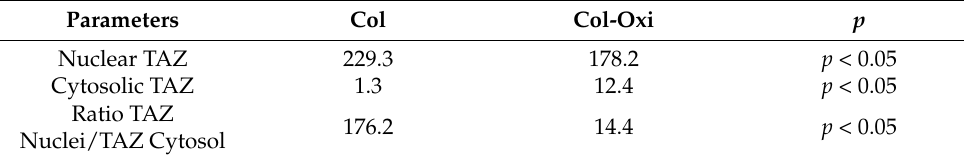
Table 3. Nuclear and Cytosolic TAZ values and their